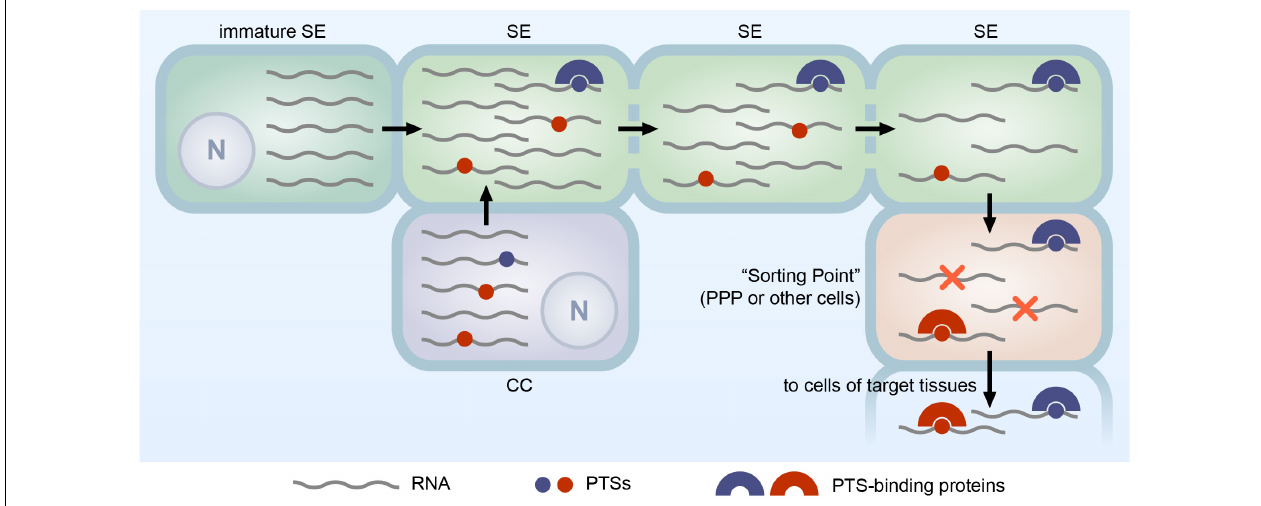
FIGURE 1 | Hypothetical model of PTS-mediated selective RNA transport through the phloem. The RNA population in mature SEs consists of molecules synthesized in immature SE and CC. Some RNA species in this population contain PTSs (shown as red and blue circles). The PTS-containing RNAs may be transferred from CCs and/or immature SEs with the bulk of RNA not destined for delivery to distant plant organs. As an alternative, a selective transport of PTS-containing RNAs from CCs into SEs has been suggested, although so far not supported by experimental data. Once in the sieve tubes, RNA can be transported to distant plant organs. Many RNAs may degrade during the transport (shown as a decrease in the number of RNA molecules per SE ). During transport, RNAs containing PTSs (blue circles) can be stabilized by interaction with PTS-binding proteins (blue half-rings) resulting in formation of transport complexes. In target tissues, RNAs are transported from the SEs into a “Sorting Point,” cells where the further fate of the delivered RNAs is determined. In the case of root tips, the “Sorting Point” is PPP cells, whereas in other organs, such as leaf minor veins, cells of other types may play this role. In the “Sorting Point,” PTS-binding proteins may enable the selective exit of PTS-containing RNAs into surrounding cells. RNAs lacking PTSs are supposed to be confined in the “Sorting Point” and degrade (shown by red crosses). In this model, PTS-binding proteins enabling RNA delivery to destination tissues have two functional roles, (i) protection of RNA during the translocation through the phloem and (ii) the selective cell-to-cell transport of PTS-containing RNAs from the “Sorting Point” to cells of a target tissue; however, it is not clear whether both roles can be played by a single PTS-binding protein. N,